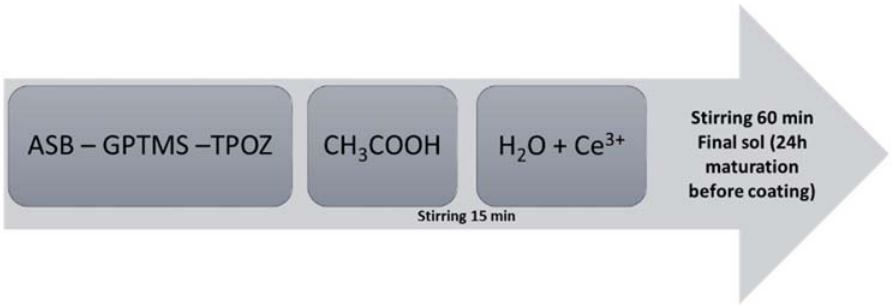
Figure 17. Formulation process for sol preparation.